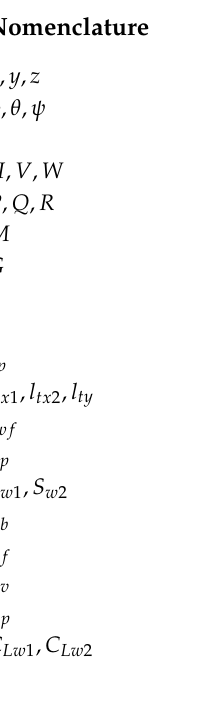
Figure 18. Experimental result of ( a ) thrust, ( b ) flaperon angle and ( c ) tilt angle using proposed controller.